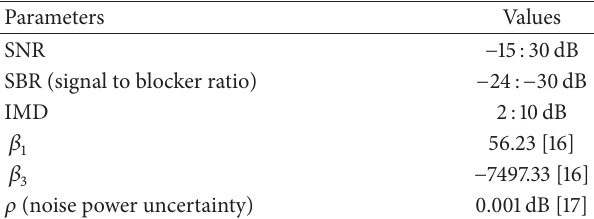
Table 1: Simulation parameters for non-Poisson field of interferer. Parameters